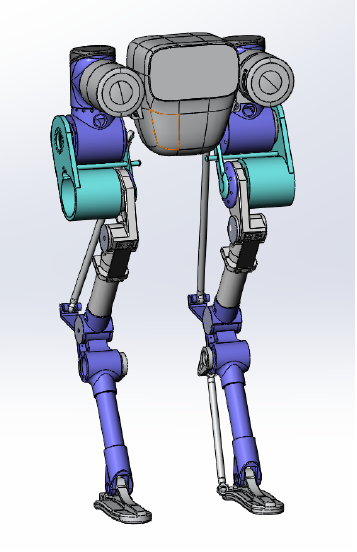
Figure 1. Simulation model of biped robot.